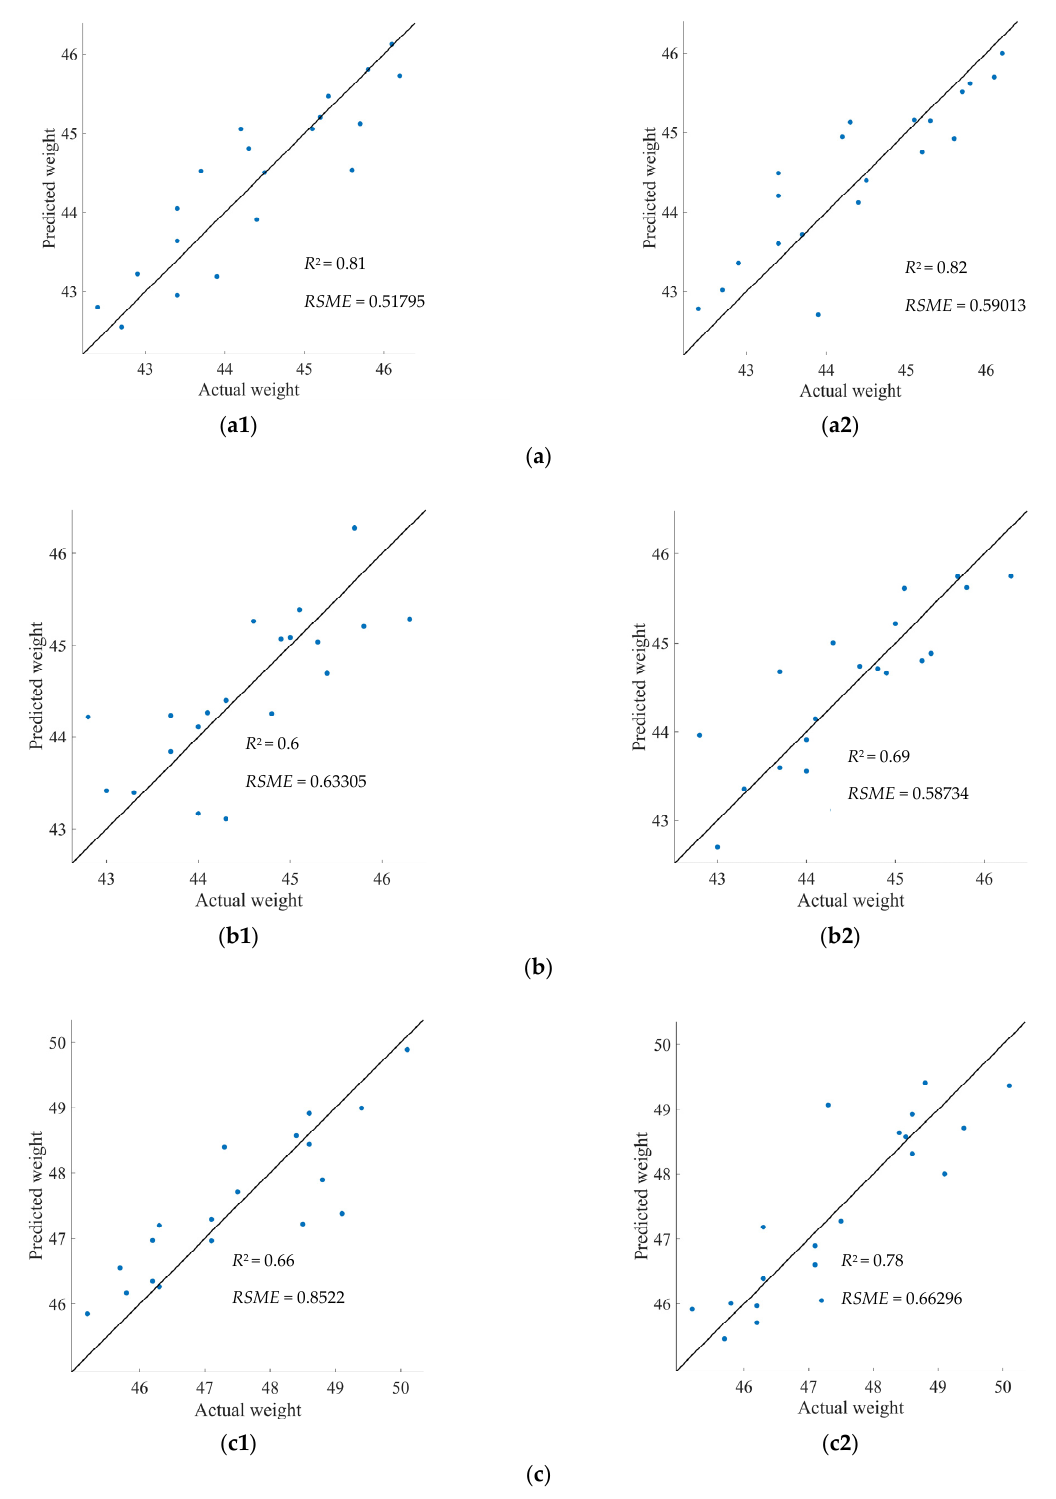
Figure 9. Predictive model validation. ( a1 ) Predictive model based on PCA–MLR. ( a2 ) Multiple linear regression prediction model. ( a ) Thousand seed weight prediction model of Jinqiang 11. ( b1 ) Predictive model based on PCA–MLR. ( b2 ) Multiple linear regression prediction model. ( b ) Thousand seed weight prediction model of Bainong 207. ( c1 ) Predictive model based on PCA– MLR. ( c2 ) Multiple linear regression prediction model. ( c ) Thousand seed weight prediction model of Luohan